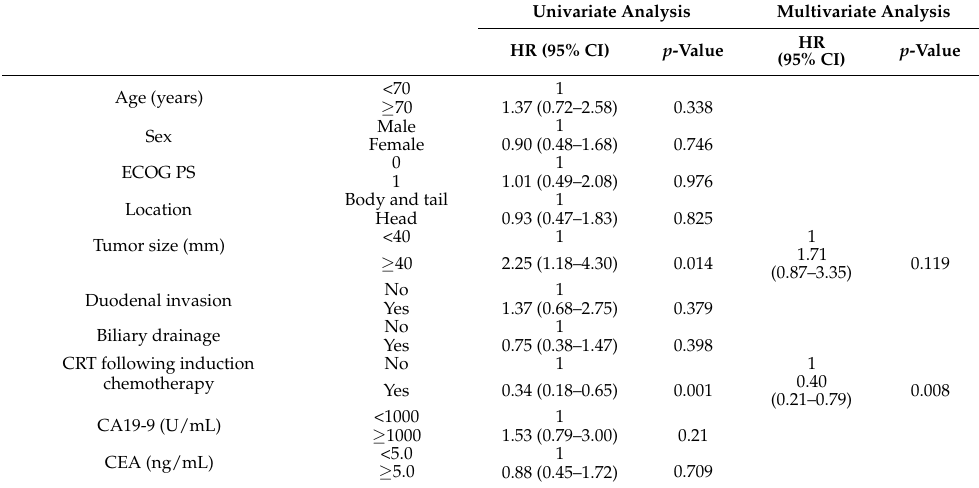
Table 4. Prognostic factors associated with overall